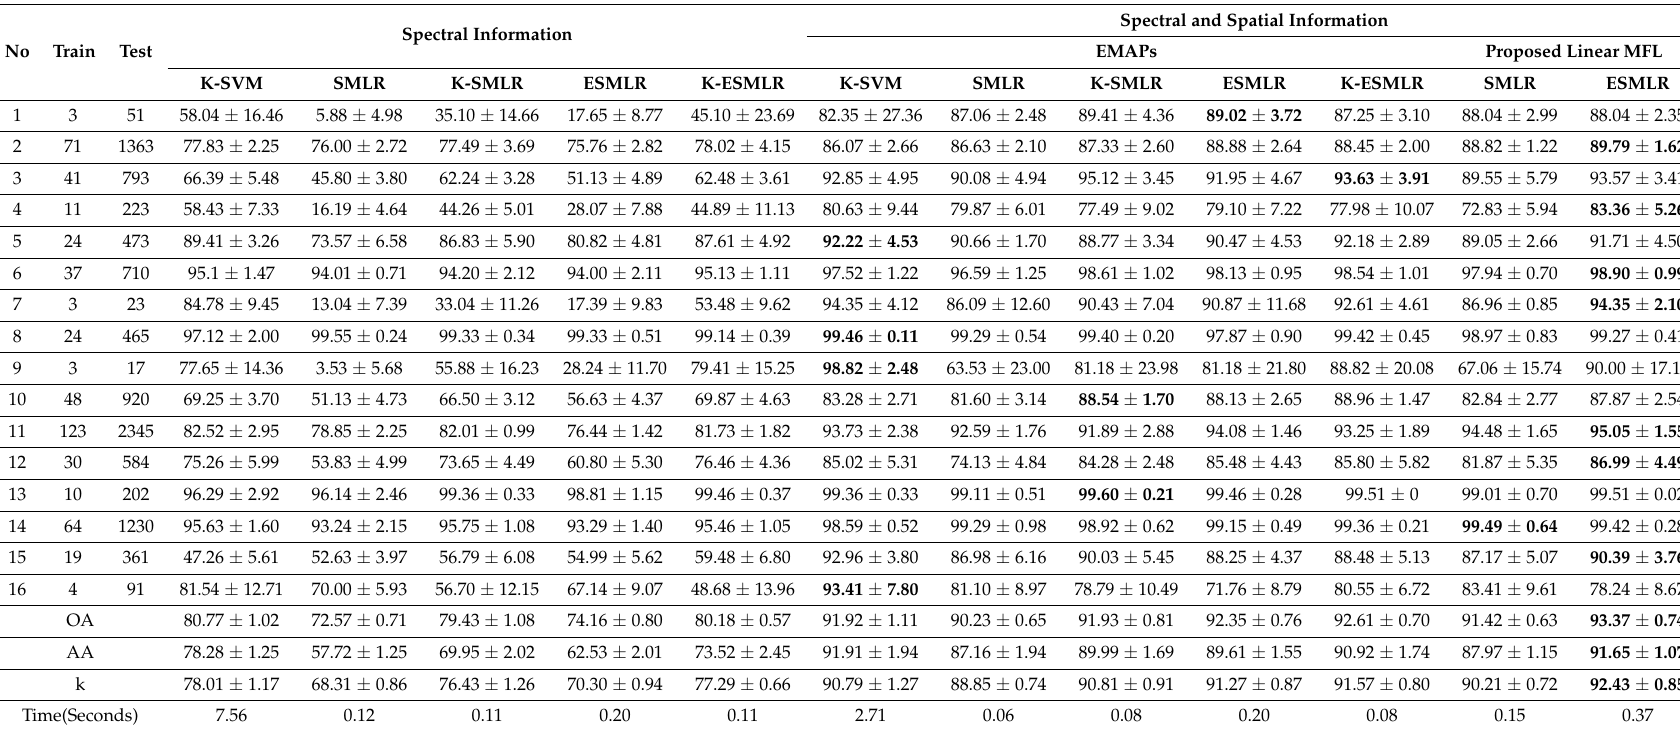
Table 1. Classification accuracy (%) with 5% labeled samples in Indian Pines dataset (Best result of each row is marked in bold